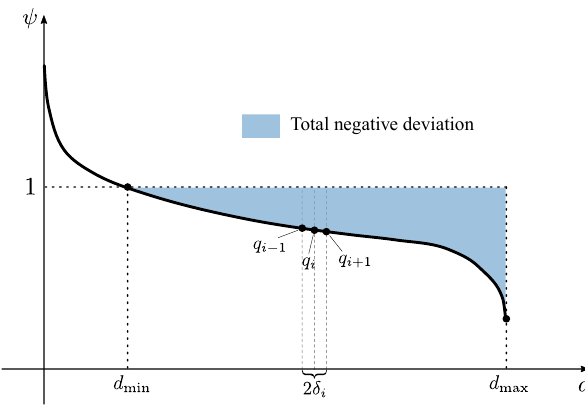
Figure 1. A sketch of the total negative deviation